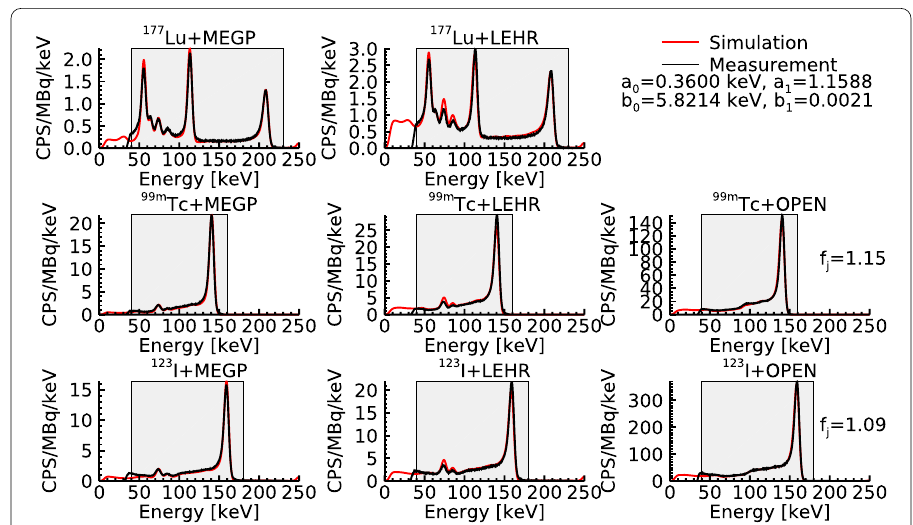
Fig. 4 Measured and simulated energy spectra for different radionuclide-collimator combinations for the optimal CIE map. The energy resolution parameters obtained from model tuning are shown, and the shaded grey areas indicate the energy intervals considered for comparison of measured and simulated spectra (Eq. 10). The two instances where f j = 1 are also indicated